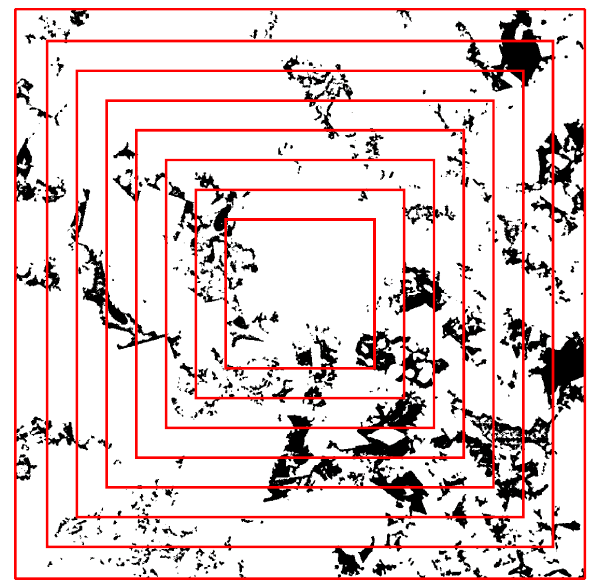
Figure 3. 2D schematic plot of cropping operation.